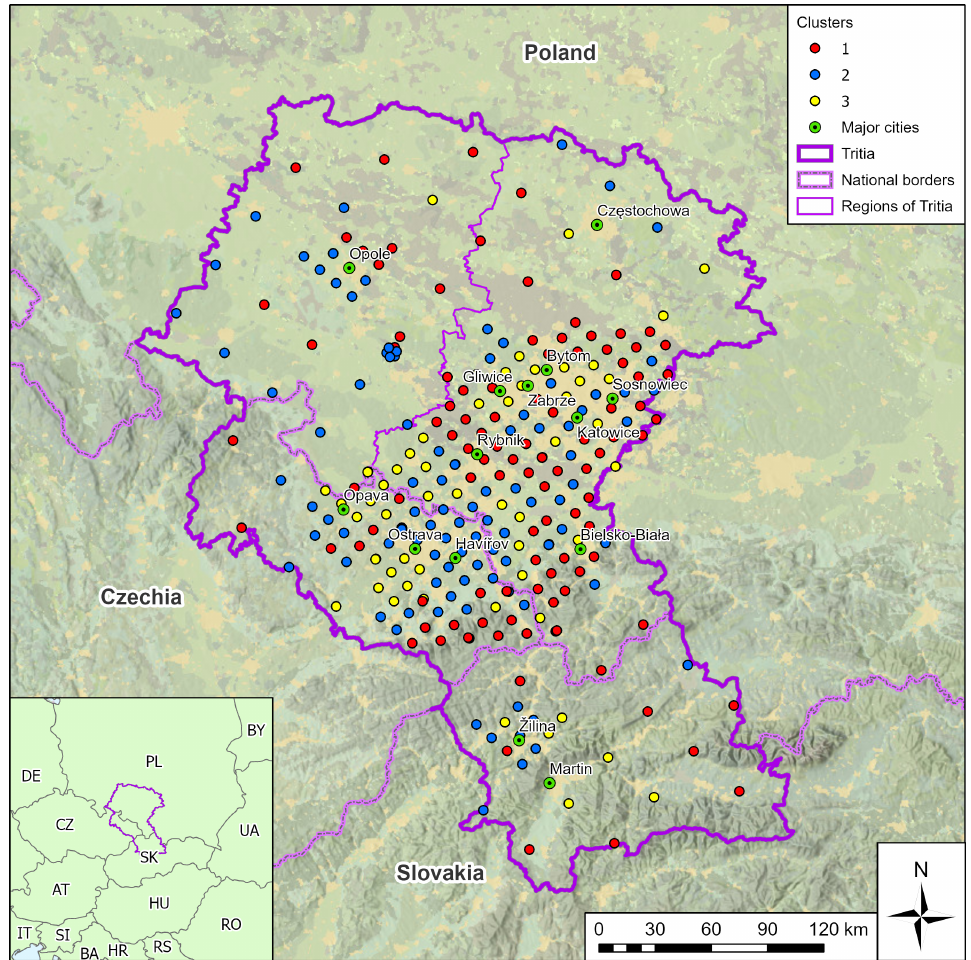
Figure 12. Map of the resulting clusters—the points are coloured in accordance to their cluster in the cluster